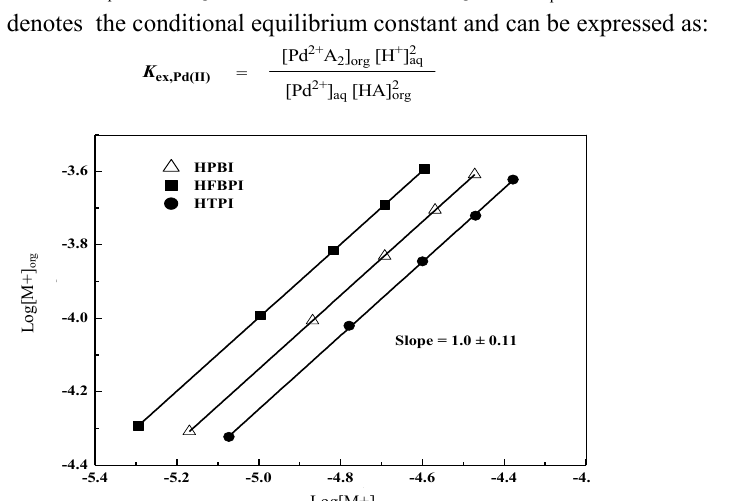
Figure 5. Effect of the metal ion concentration on Pd(II) extraction with 4-aroyl-3-phenyl-5- isoxazolones(HA). Aqueous phase = 0.5 × 10 - 4 - 2.8 × 10 - 4 mol L -1 Pd(II) at 0.05 mol L -1 H + and 1.0 mol L -1 ionic strength, Organic phase = 1.0 × 10 -3 mol L -1 in CHCl